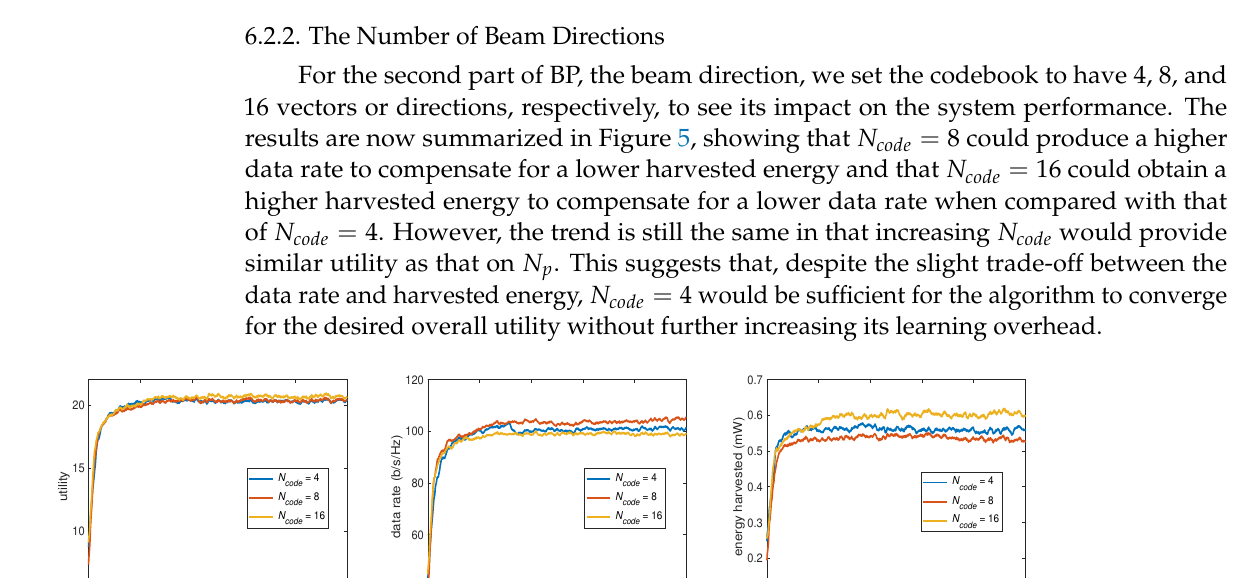
Figure 4. System performance by varying N p : ( a ) utility, ( b ) data rate, and ( c ) harvested energy.